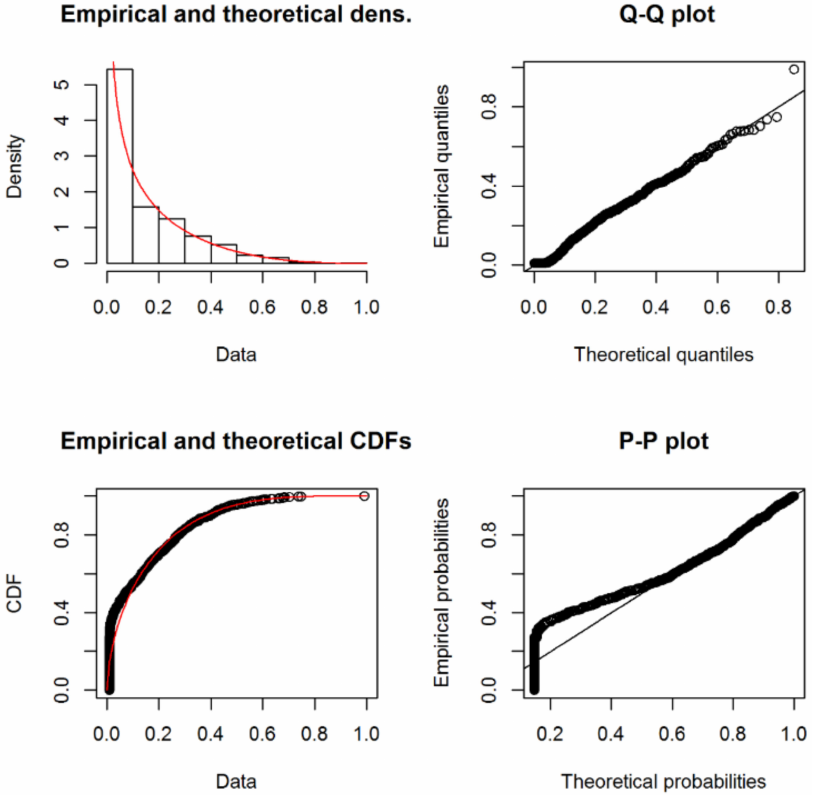
Figure 7. The goodness of fit of the observed areal average monthly precipitation in Iraq using beta